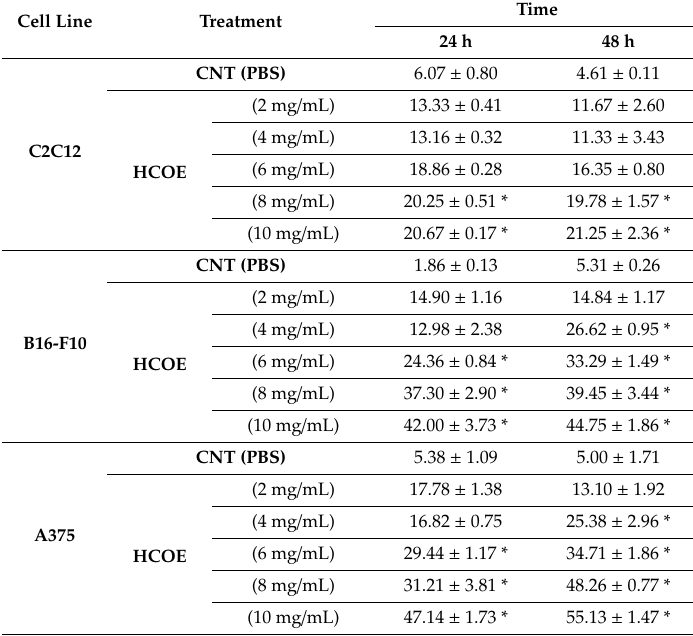
Table 3. Cytotoxicity analysis. The percentages of C2C12, B16-F10, and A375 dead cells identified by the Trypan Blue test after 24 and 48 h of HCOE treatment are reported. Data are reported as mean ± SD of four independent replicates. (* p < 0.05 vs.